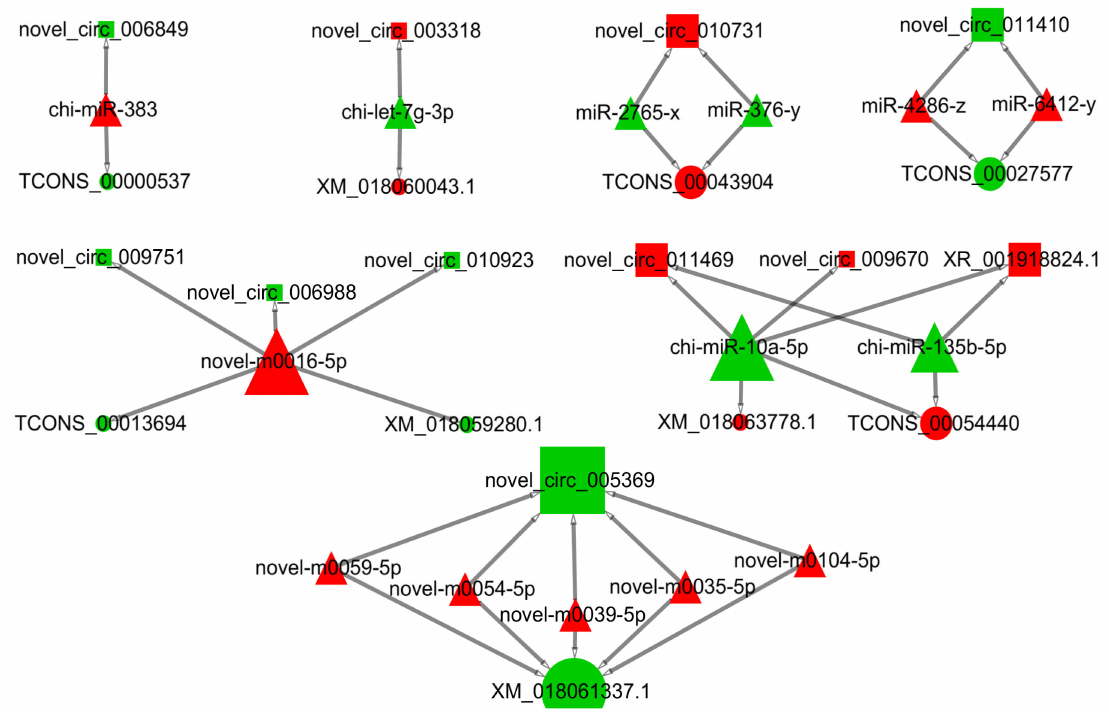
Figure 4. LncRNA/circRNA–miRNA–mRNA ceRNA network. Rectangles indicate lncRNA or circRNA, triangles represent miRNAs, and circles represent mRNAs. Red indicates up-regulation, and green indicates